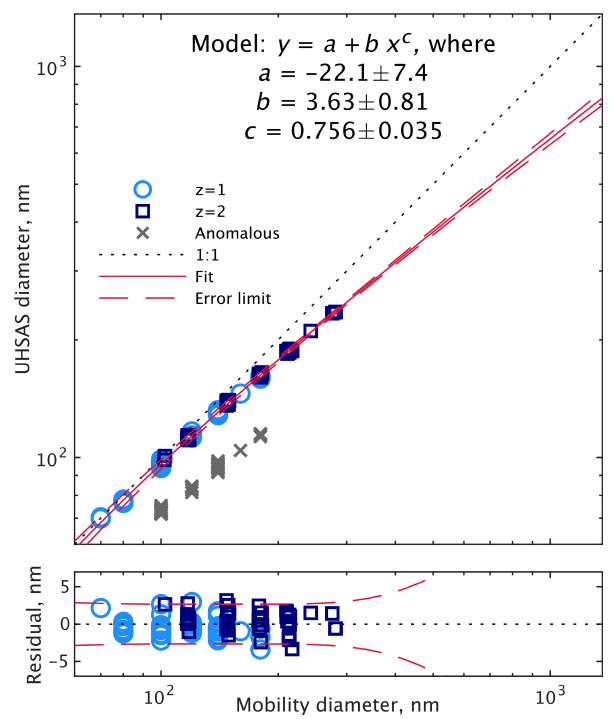
Figure 7. UHSAS-reported diameters while sampling size-selected particles from the DMA during flight. Only the singly and doubly charged particles were used in the curve fit; the anomalous particles were excluded (error bounds are 95% confidence limits within the fitting range). The bottom plot shows the